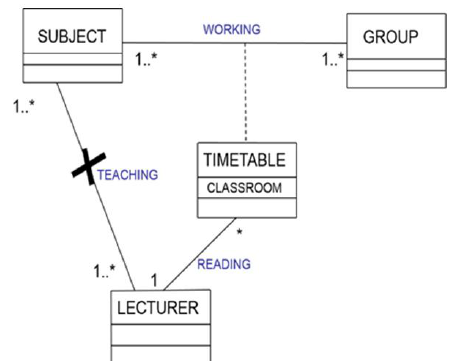
Fig. 2. Example of the anti-pattern "Cycle of association relations, including the class-association".